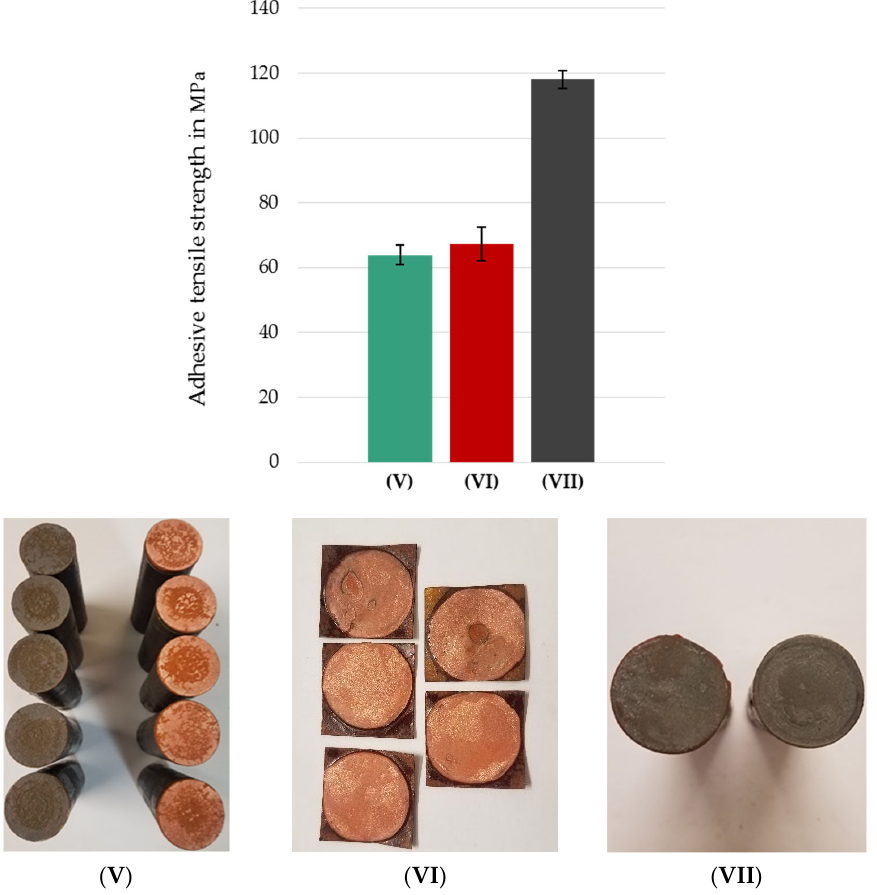
Figure 14. Adhesive tensile strength and fracture surfaces of ( V ) samples blasted and coated in silane ‐ doped nitrogen, ( VI ) pure copper sheets, and a ( VII ) control sample from sample set ( V ). Ultrabond 100 is known to feature a decrease in adhesive properties over time [41].